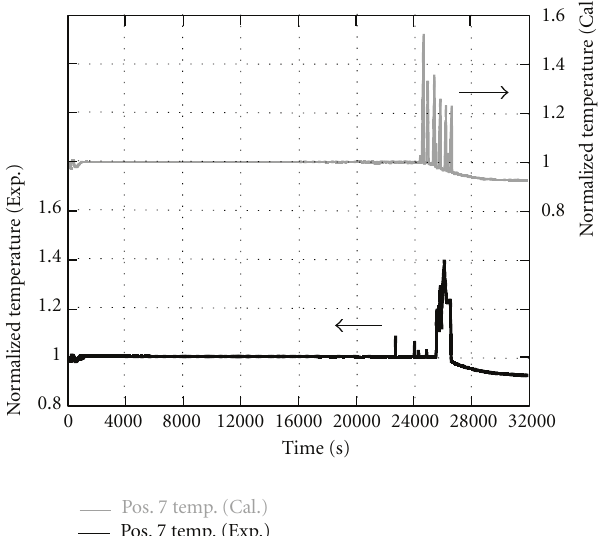
Figure 19: LSTF and RELAP5 results for cladding surface tempera- ture.